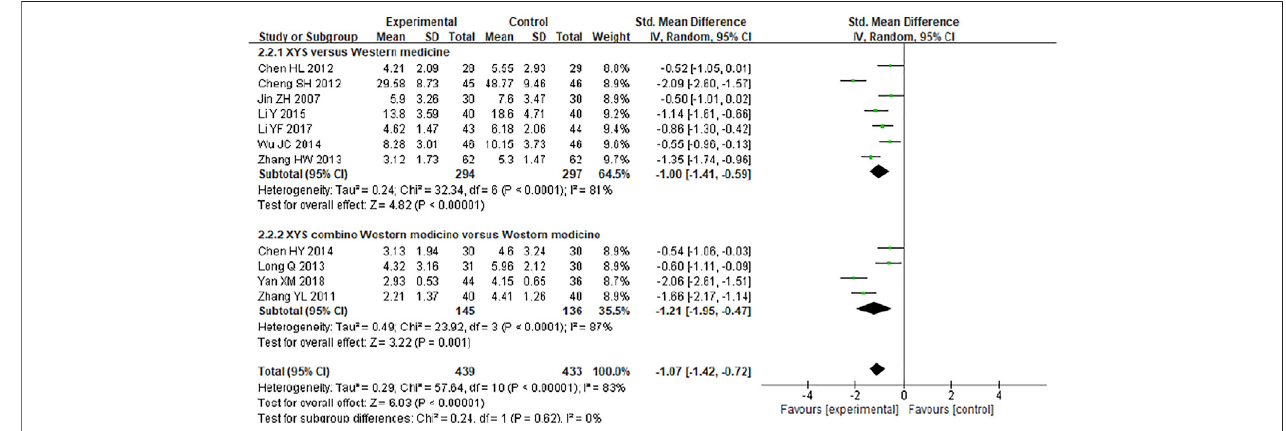
FIGURE 4 | Forest plot of comparison of symptom scores.